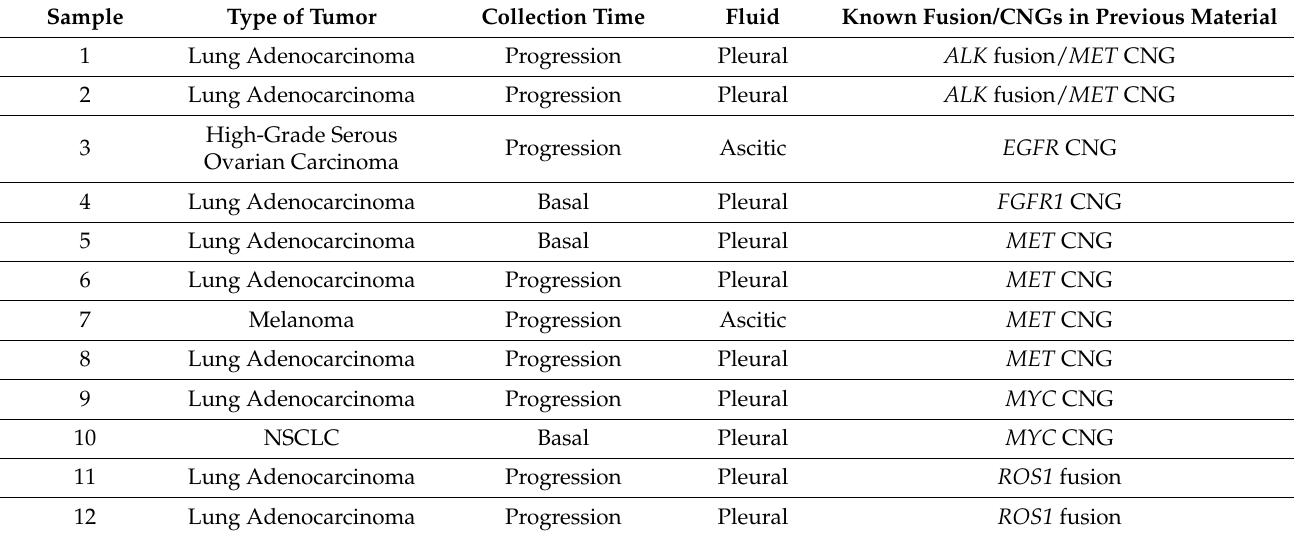
Table 1. Types of fluids collected and known alterations in each sample.